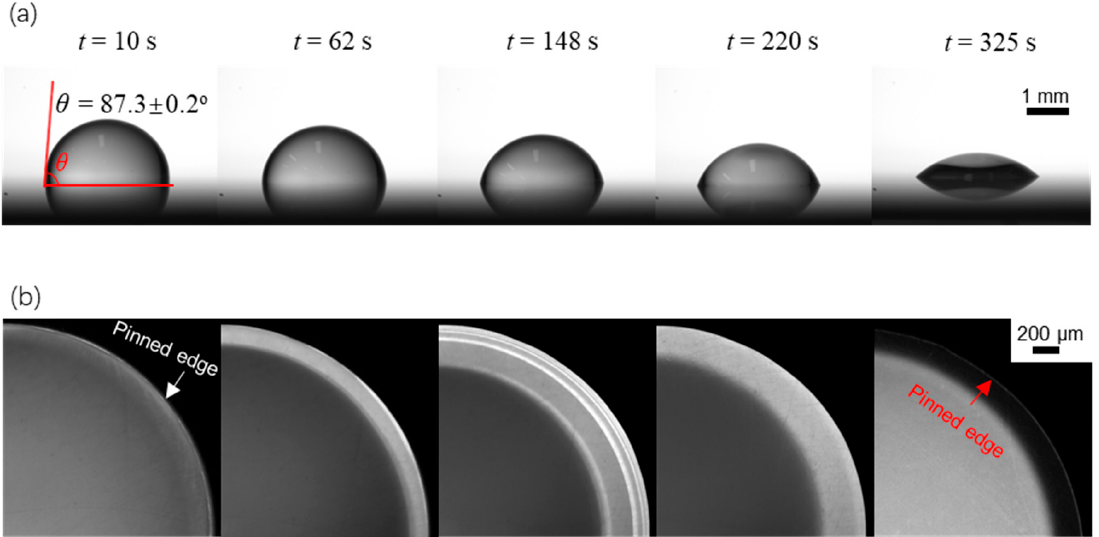
Figure 4. Evaporation dynamics of an evaporating sessile water drop on a surface with an initial contact angle of θ 0 = 87.3 ± 0.2°. ( a ) side-view images showing variation of the drop contact angle with time; ( b ) top-view images showing variation of the fluorescence intensity over time.